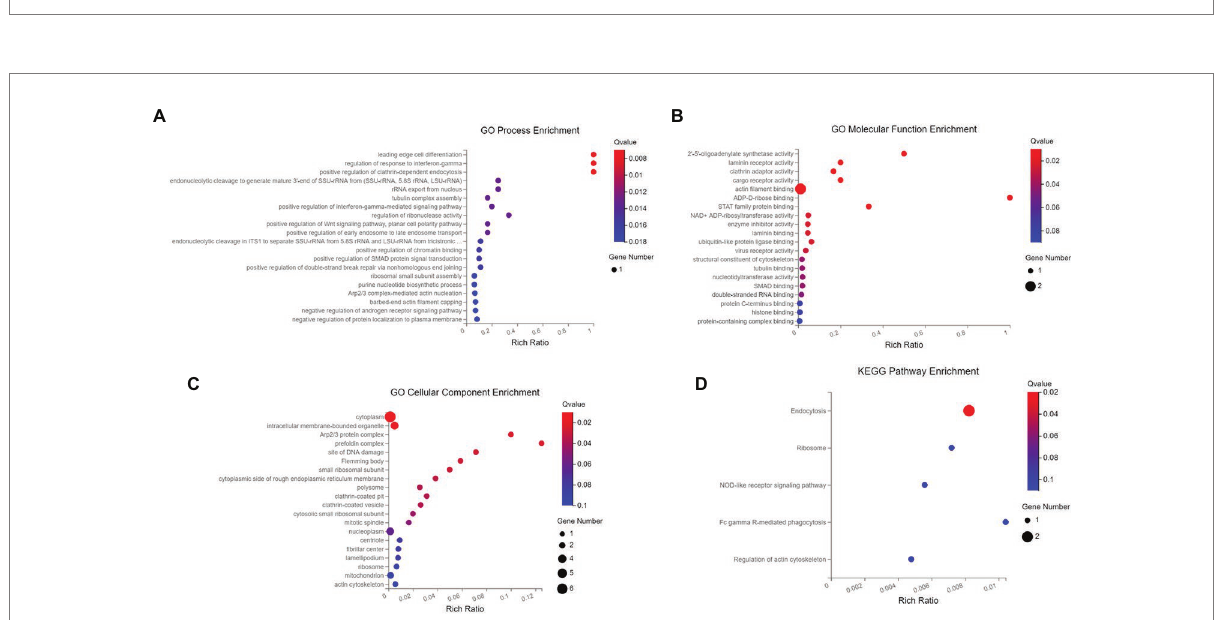
FIGURE 6 GO and KEGG pathway0 enrichment analysis. (A) The biological process of GO enrichment; (B) molecular function of GO enrichment; (C) cellular components of GO enrichment; (D) KEGG pathway enrichment. The enriched databases targeted by ASFV p30-interacting proteins. The terms that were significantly enriched ( p < 0.05) were